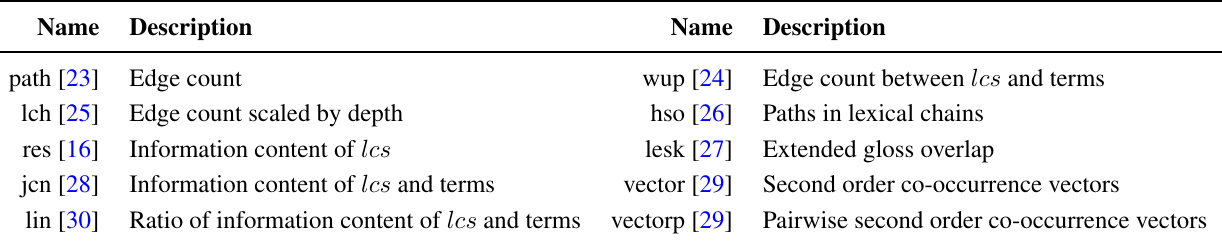
Table 1. WordNet-based similarity measures. lcs: least common